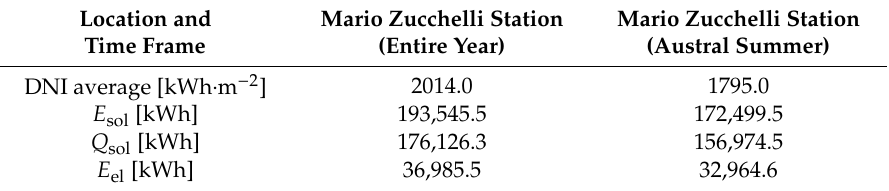
Table 4. Performance of parabolic dish, annually and in the summer